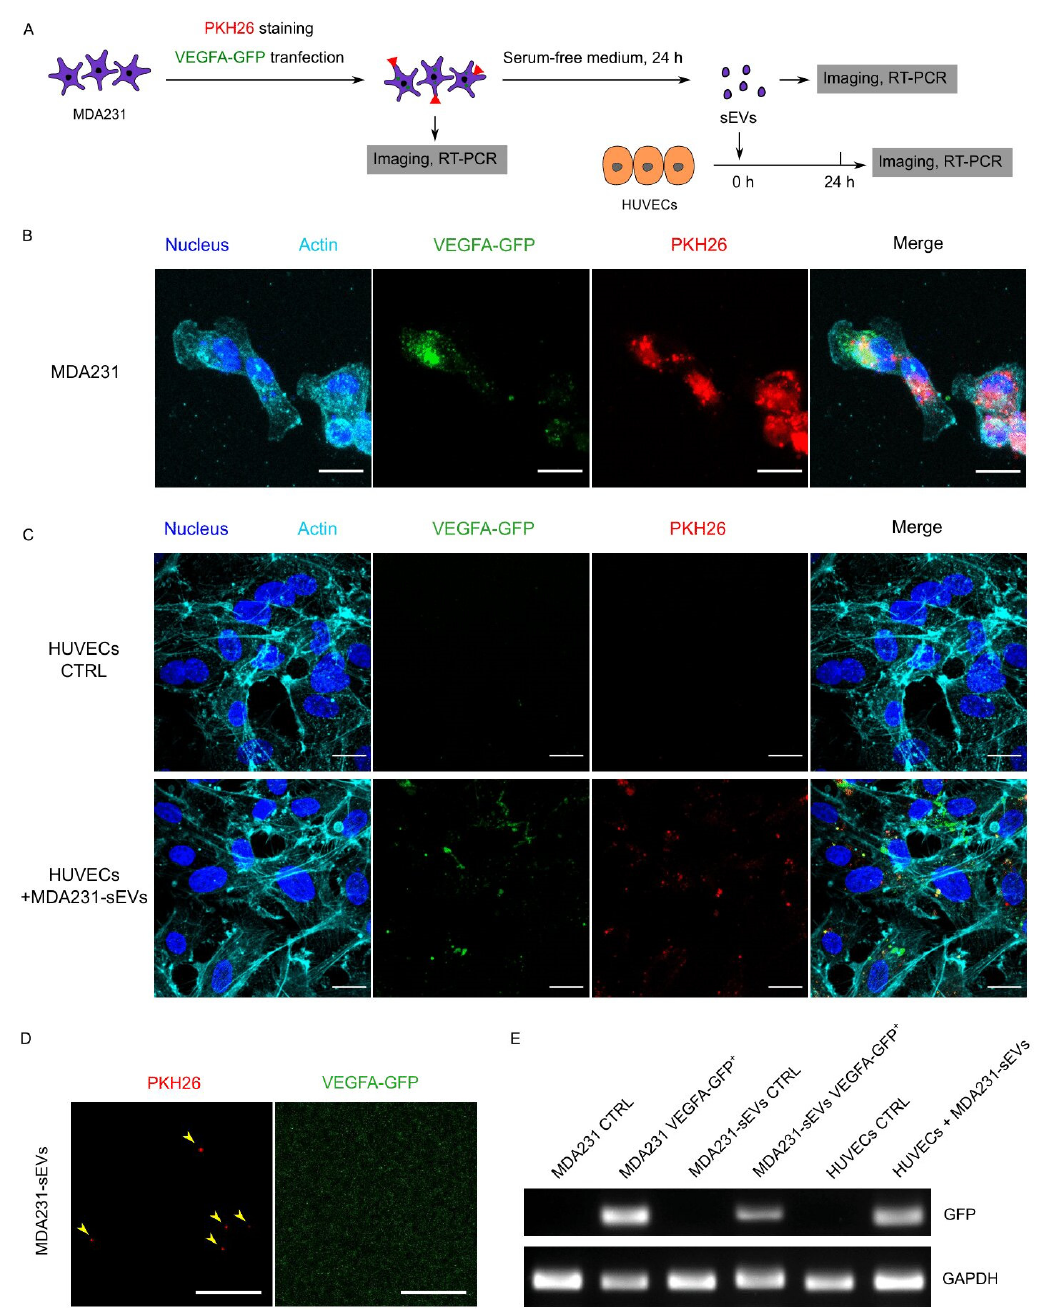
Figure 4. Internalization and translation of cancer EV-delivered VEGFA-GFP mRNA by HUVECs. ( A ) MDA231 cells were stained with PKH26 and transfected with VEGFA-GFP, as shown in ( B ). This stained MDA231 was then incubated in serum-free culture medium to generate EVs. These EVs (50 µg/mL) were used to treat HUVECs for 24 h. ( C ) After 24-h co-culture with the PKH26 + VEGFA-GFP mRNA + EVs derived from ( B ), HUVECs internalized the PKH26 + EVs and synthesized VEGFA-GFP protein from the EV-mRNA. Scale bars = 20 µm for ( B , C ). ( D ) No detectable level of VEGFA-GFP protein was harbored by the PKH26 + EVs derived from ( B ). Scale bars = 5 µm for ( D ). ( E ) DNA gel electrophoresis showed that the VEGFA-GFP + MDA231 transferred VEGFA-GFP mRNAs to HUVECs through EVs.